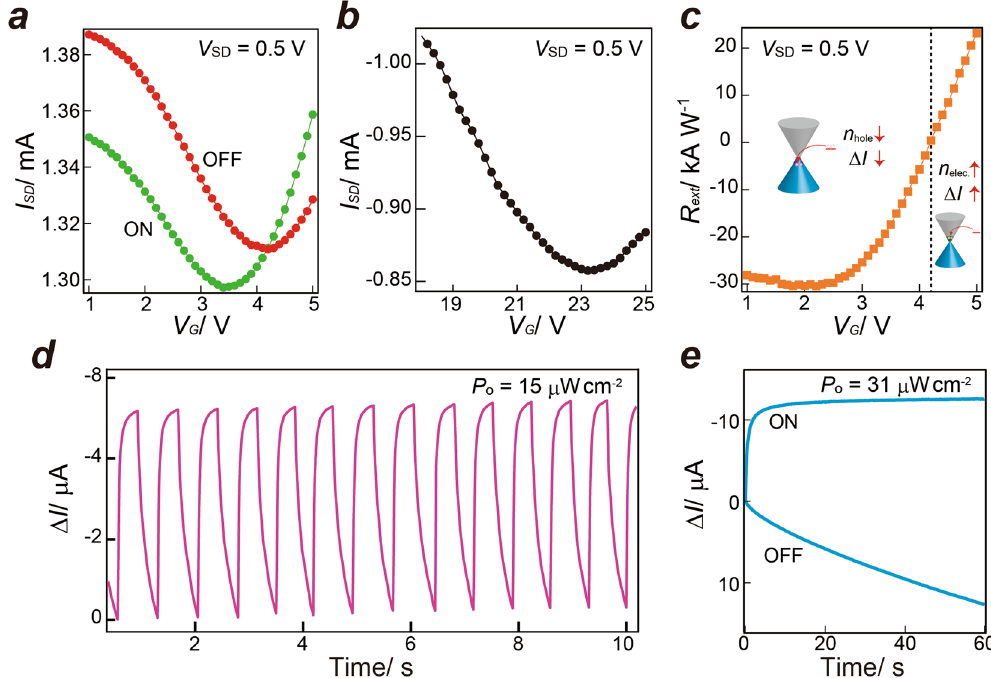
Figure 2. ( a ) I SD – V curve ( V SD = 0.5 V) for the ON (405 nm, 18 μ W cm − 2 ) and OFF states of a NMe 2 -GQD@ GFET photodetector. ( b ) I SD – V curve ( V SD = 0.5 V) for a pristine GFET. ( c ) Photoresponsivity as a function of gate voltage. Insets show the direction of electron transfer from the NMe 2 -GQDs to graphene for the hole and electron conduction regimes in graphene under illumination (405 nm, 18 μ W cm − 2 ). ( d )